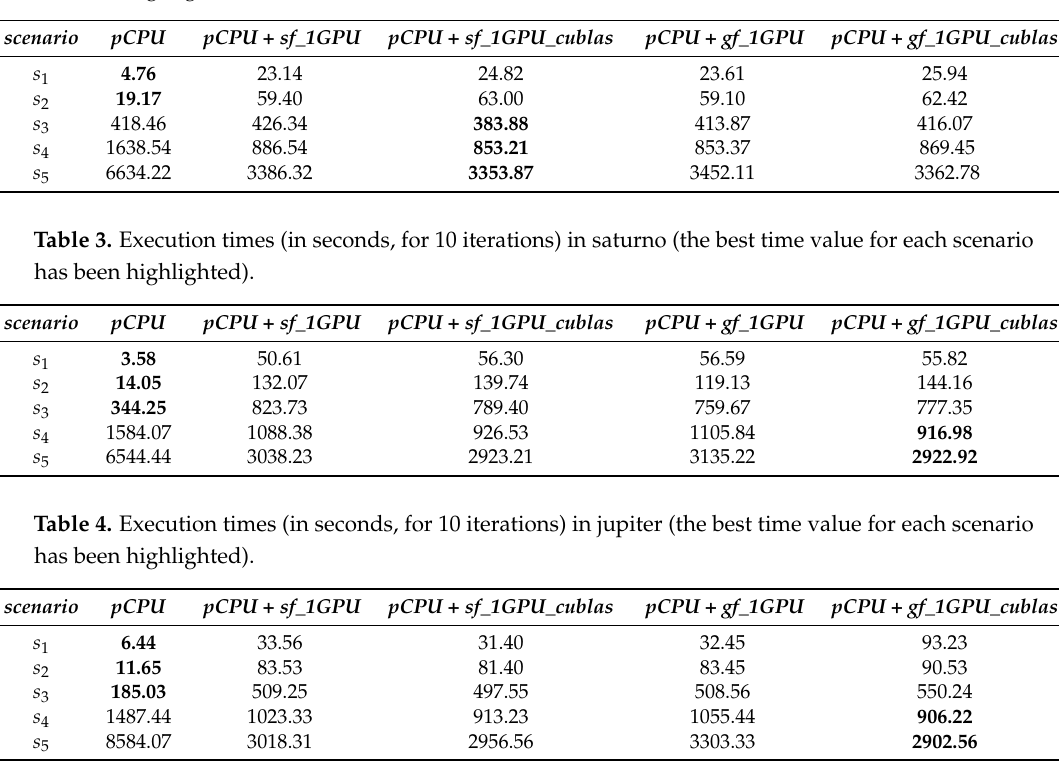
Table 2. Execution times (in seconds, for 10 iterations) in marte (the best time value for each scenario has been highlighted).